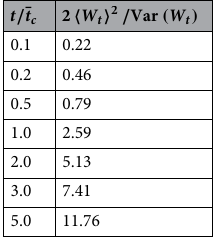
¯ t = 1 and p = 0.2 c for a system with M l